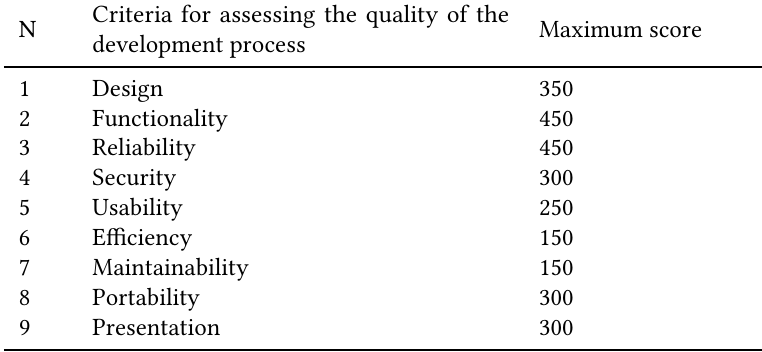
Criteria for assessing the quality of the development process